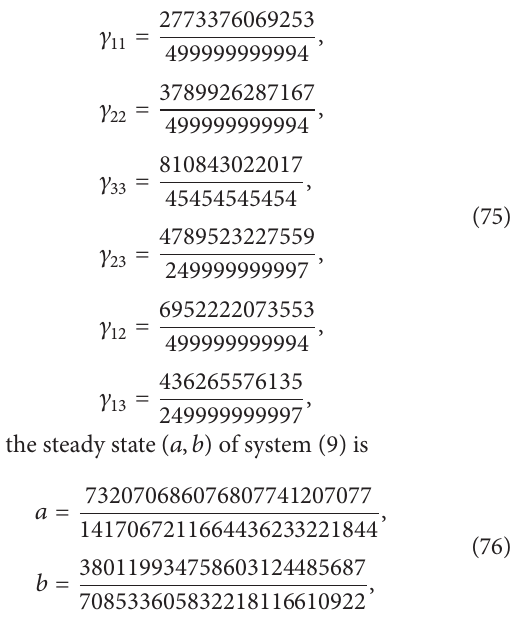
Figure 1: Turing patterns in two dimensions of system (9) with 𝛾 𝑖𝑗 defined by